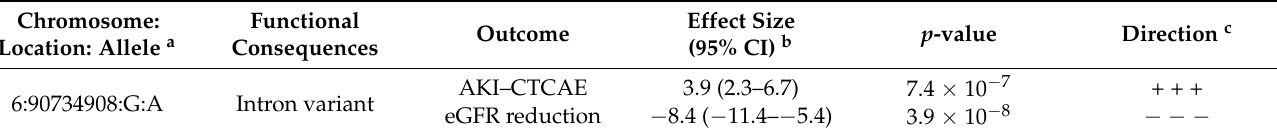
Table 3. Association between BACH2 rs4388268 and cisplatin-induced nephrotoxicity in the discovery cohort.